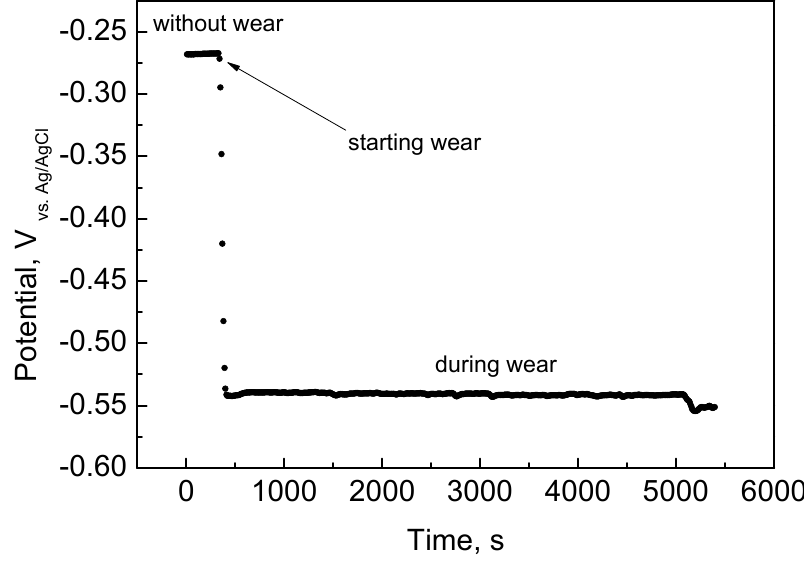
Figure 1. Open circuit potential of HCCoCr disks under wear. Measurement of the open circuit potential before and during the wear corrosion test of HCCoCr in PBS containing 3 g/L HA (PBS-HA).